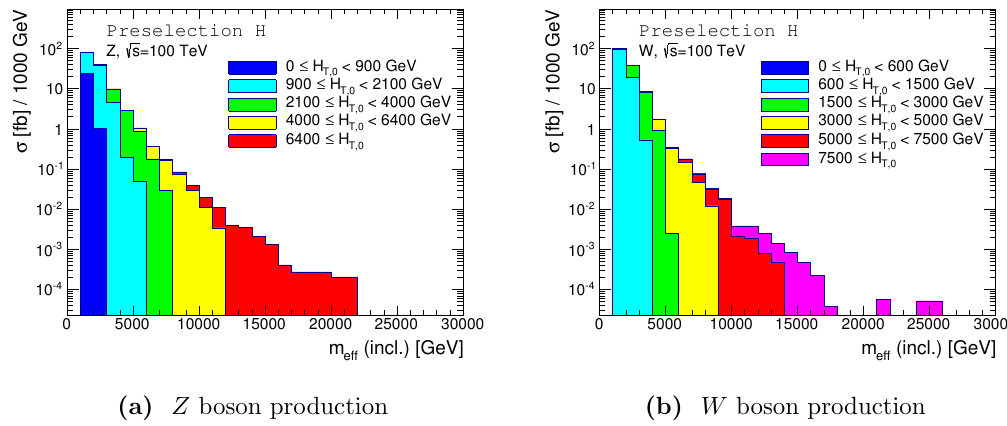
(a) Z boson production (b) W boson production Figure 15. Distributions of m preselection-H required. Contributions from di(cid:11)er- e(cid:11) (incl.) with